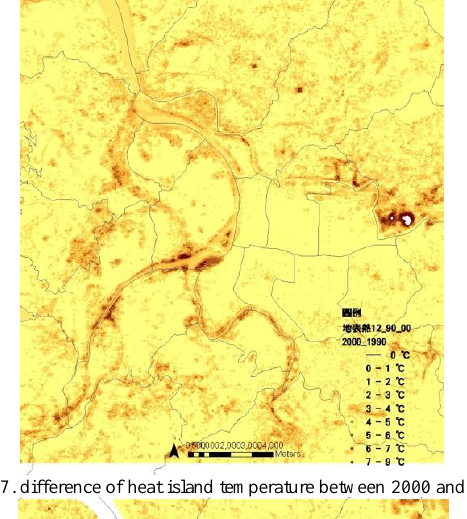
Figure 7. difference of heat island temperature between 2000 and 1990